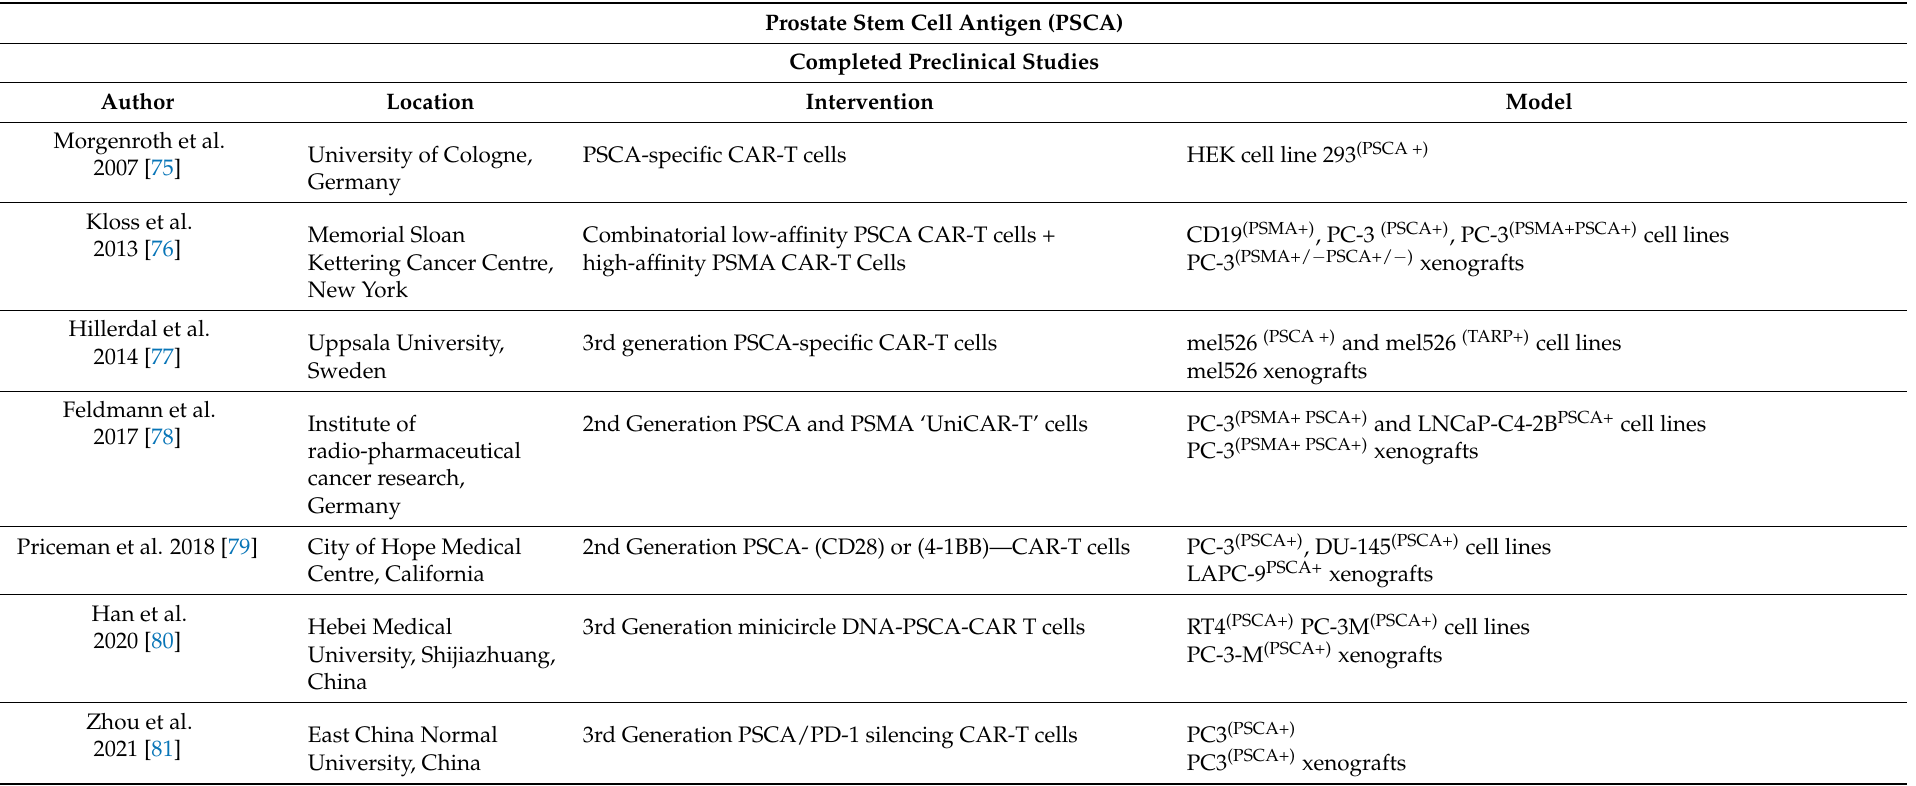
Table 2. Current preclinical and clinical trials involving prostate stem cell antigen (PSCA) and epithelial cell adhesion molecule